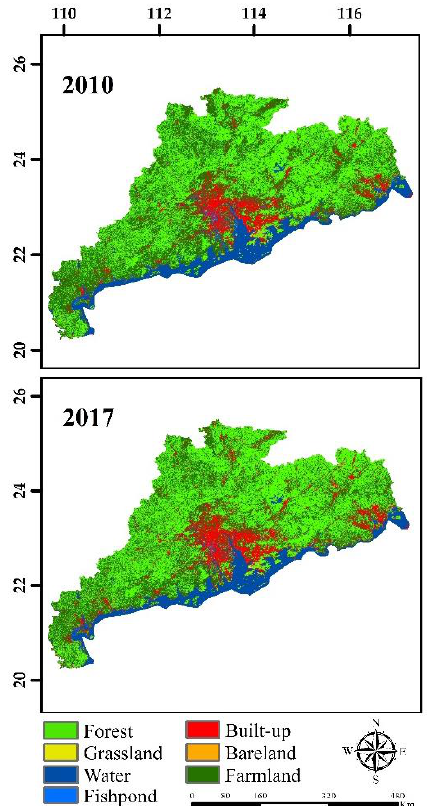
Figure 2. Guangdong, Hong, and Macao land use land cover classification map (2010 — 2017)